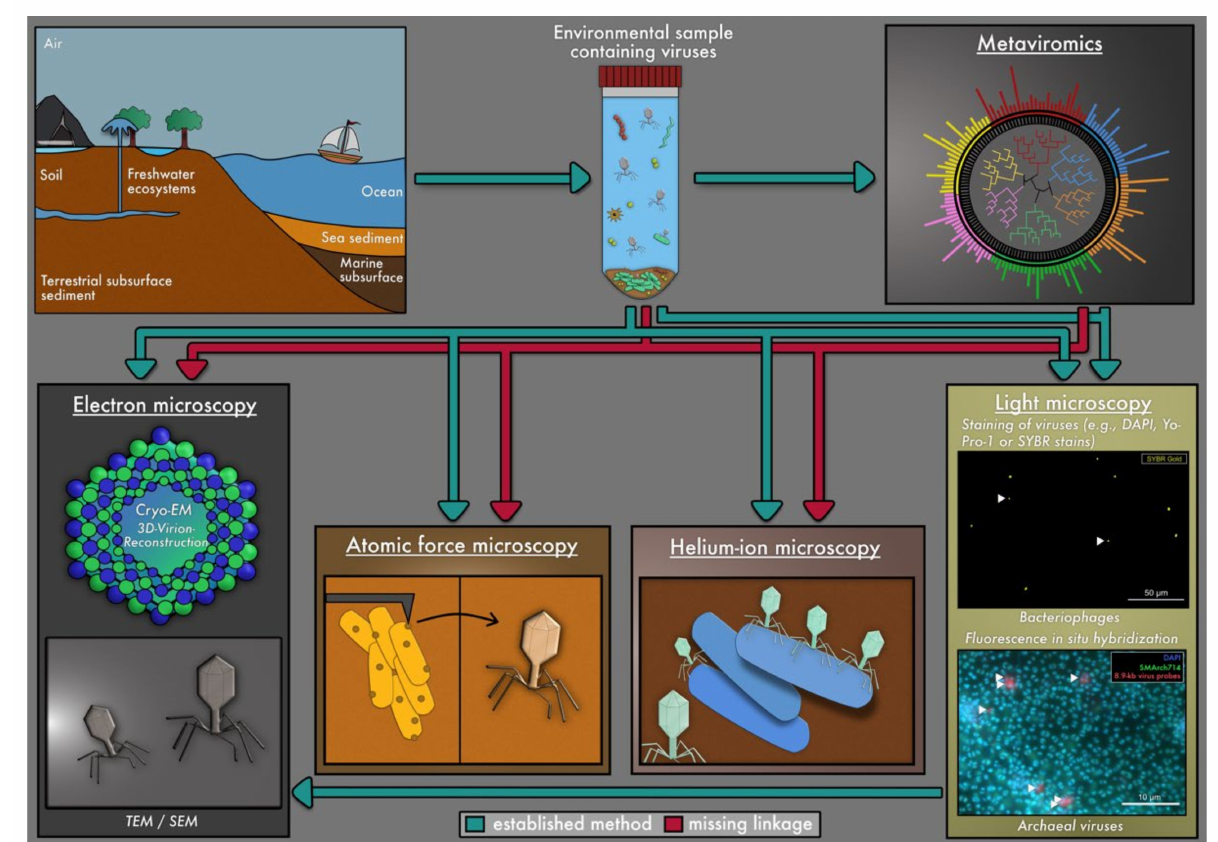
Figure 1. Overview of methods for detecting viruses in environmental samples and combinations thereof. Green arrows indicate commonly applied methods, which are described in the main text. Red arrows suggest potential couplings of methods that have not been performed to date. Coupling metaviromics with light microscopy has been performed in three studies (Rahlff et al., 2021 [10], Hochstein et al., 2016 [34], Jahn et. al., 2021 [26]) and is elucidated further in Figure 2. The origin of arrows in the figure is always associated with the environmental sample and the metaviromics analysis to indicate that both need to be combined to link viral structures to genome sequences.